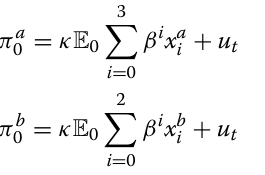
Fig. 1 The optimal persistence in the policy rule. The inflation rate, the output gap, and the cost-push shock under two policy simulations. Simulation a (dashed lines) assumes central bank credibilities { γ b } T + 1 = { 1,1,0,0 } . In both simulations, the sequence of cost-push shocks is { u t t = 0 optimalpersistenceinthepolicyrule,theimpactcoefficientsofthecost-pushshockontheoutputgap( ˆ h j t )areequalizedacrosssimulations j = { a , b